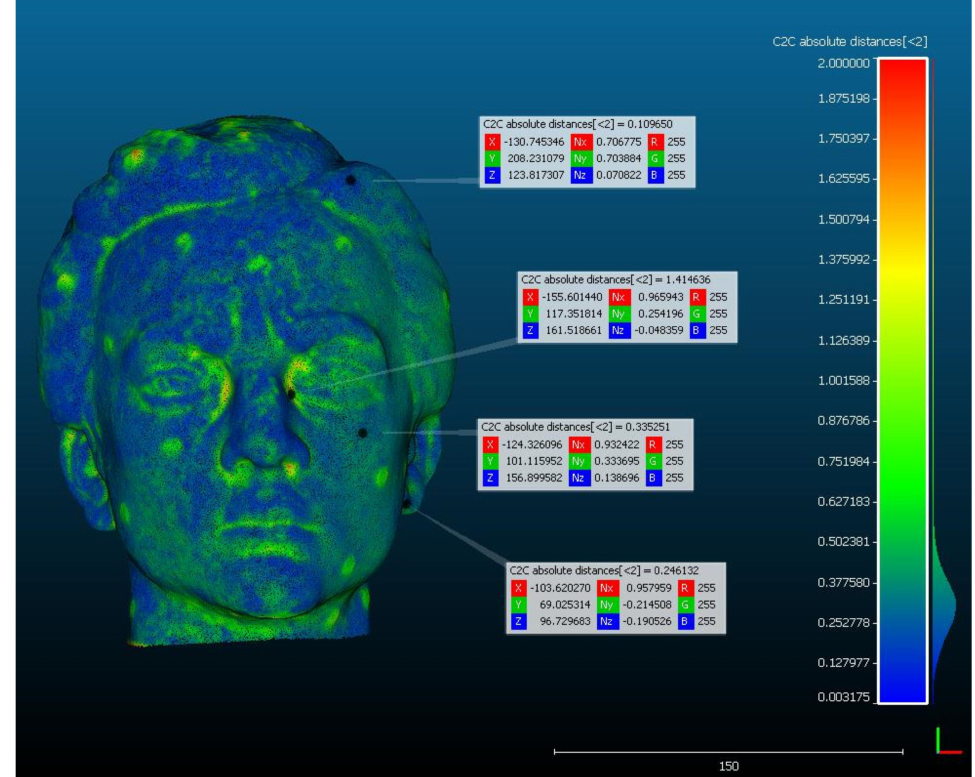
Figure 12. Results of the comparison of the original models obtained by scanning and photogramme- try in CloudCompare